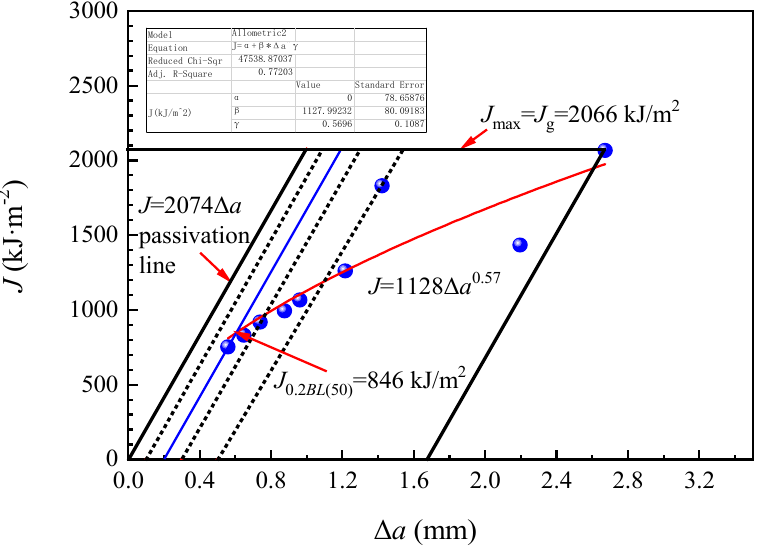
Figure 10. J - ∆ a resistance curve of FH36 steel Figure 10. J - Δ a resistance curve of FH36 steel plate.